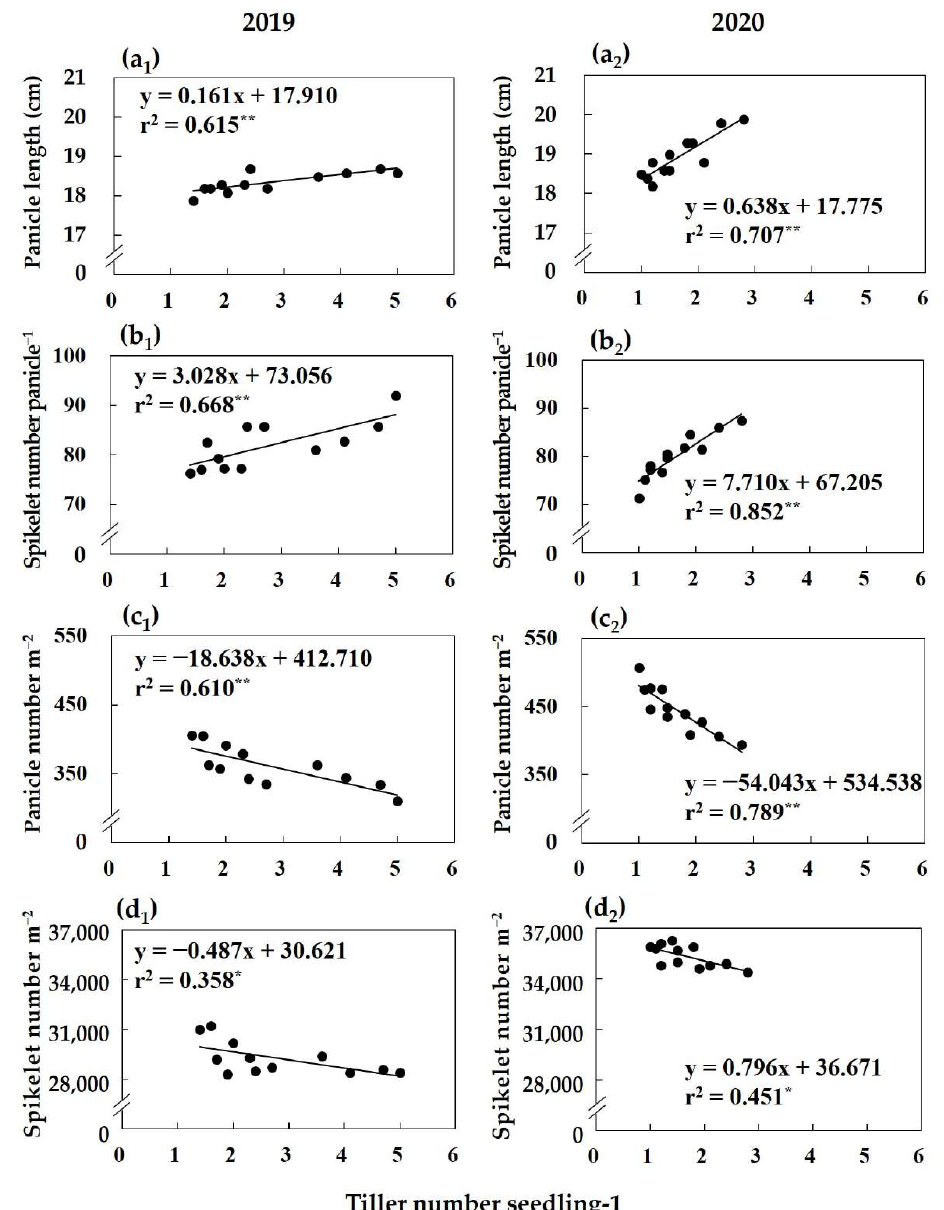
Figure 2. Relationship between the tiller number seedling − 1 and ( a 1 , a 2 ) panicle length; ( b 1 , b 2 ) spikelet number panicle − 1 ; ( c 1 , c 2 ) panicle number m − 2 ; and ( d 1 , d 2 ) spikelet number m − 2 . The tiller number seedling − 1 is calculated as the panicle number hill − 1 divided by the seedling number hill − 1 . Each data point is the mean of the replicates. * and **: significant at p < 0.05 and 0.01,